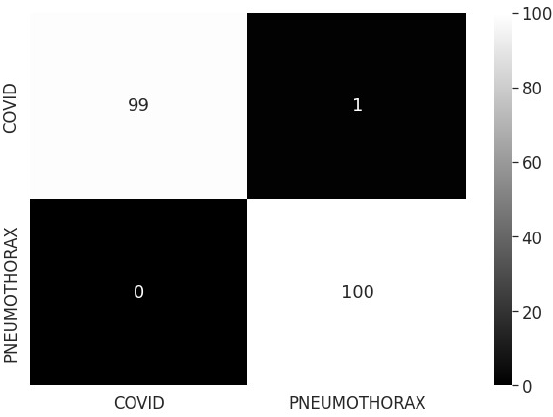
Figure 5. Confusion matrix for proposed model COVID-19/pneumothorax classification.